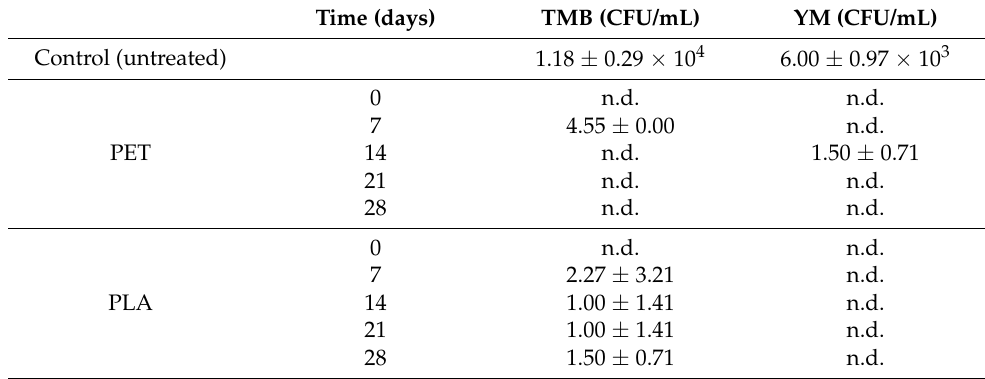
Table 1. Total mesophilic bacteria (TMB) and yeast and molds (YM) in the control (untreated) and HPP-treated apple juice during 28 days of refrigerated